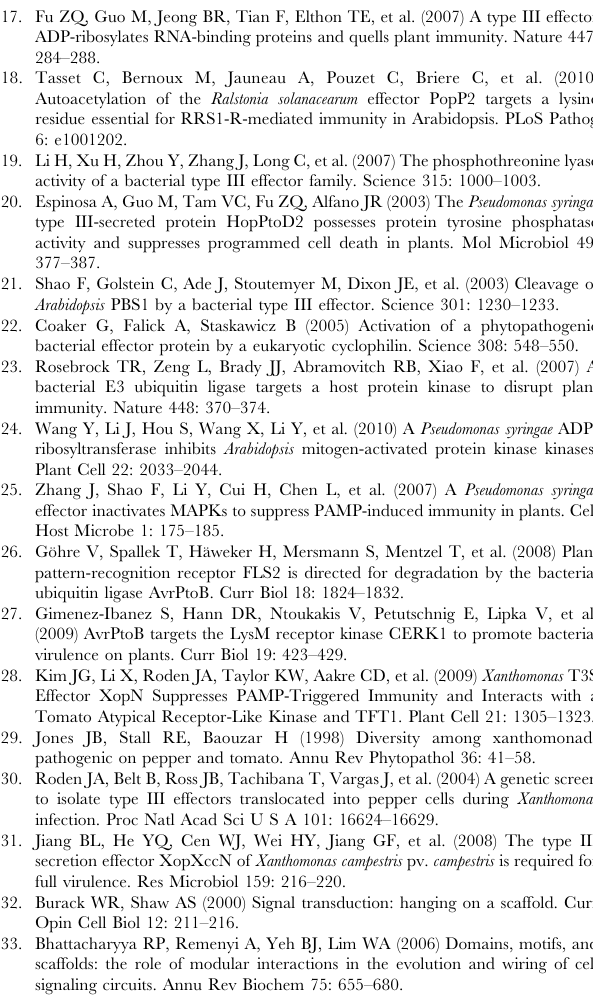
above. Anti-XopN, anti-His and anti-GFP sera were used. Figure S10 Protein gel blot analysis for TARK1/TFT1 BiFC assays shown in Figure 9A-E . Proteins were isolated from infected N. benthamiana leaves at 48 HPI and then analyzed by gel blot analysis using anti-His, anti-HA, and anti-c-Myc sera. Lane 1: